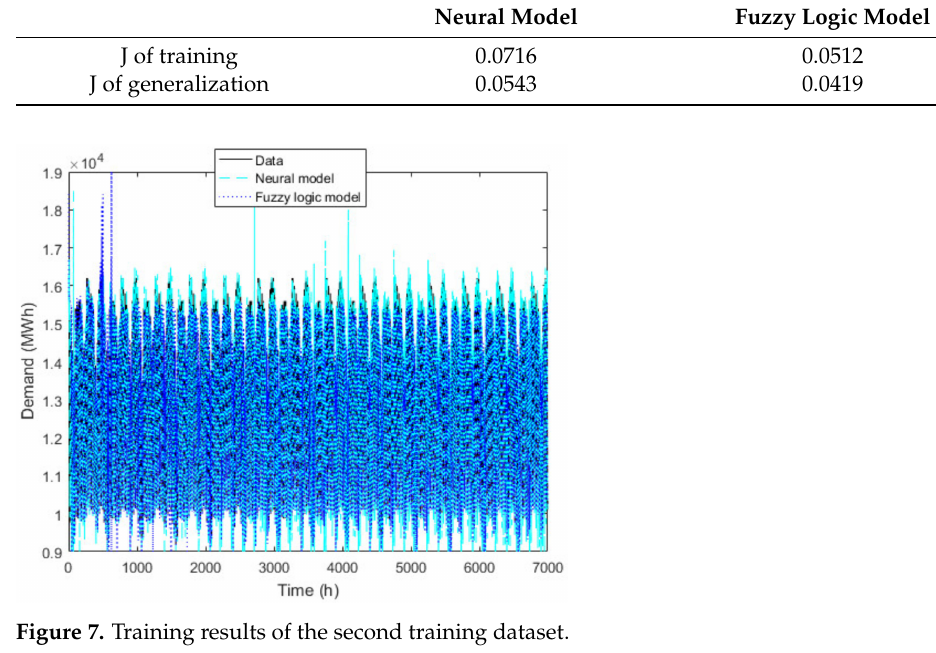
Figure 7. Training results of the second training dataset.